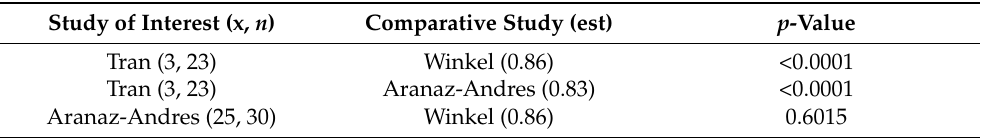
Table 4. Binomial exact test for the comparison between current study Tran et al. and Winkel et al. 2021 and Aranaz-Andres et al. 2021, all of which evaluated the performance of Abbott Panbio RAT in asymptomatic patients in periods prior to the Omicron